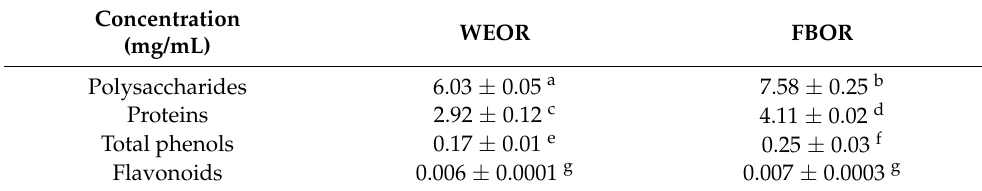
Table 1. Contents of polysaccharides, proteins, total phenols, and flavonoids in WEOR and FBOR.